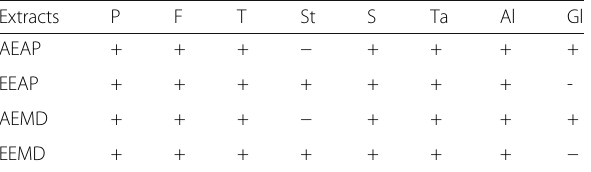
Table 1 The phytochemical profile of the prepared plant leaf extracts Extracts